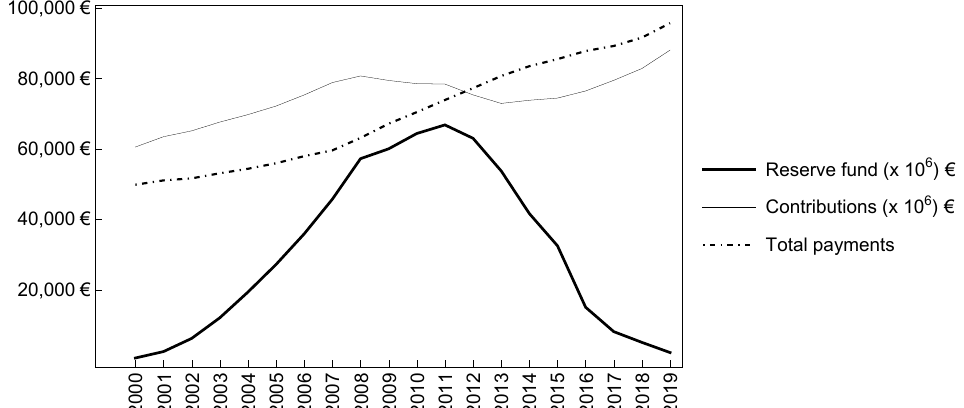
Figure 1. Evolution of the total payments in contributory pensions, the balance of the Social Security Reserve Fund and revenues from Social Security contributions in Spain during the period 2001–2019. Source: Devised by the authors, based on data offered in Table